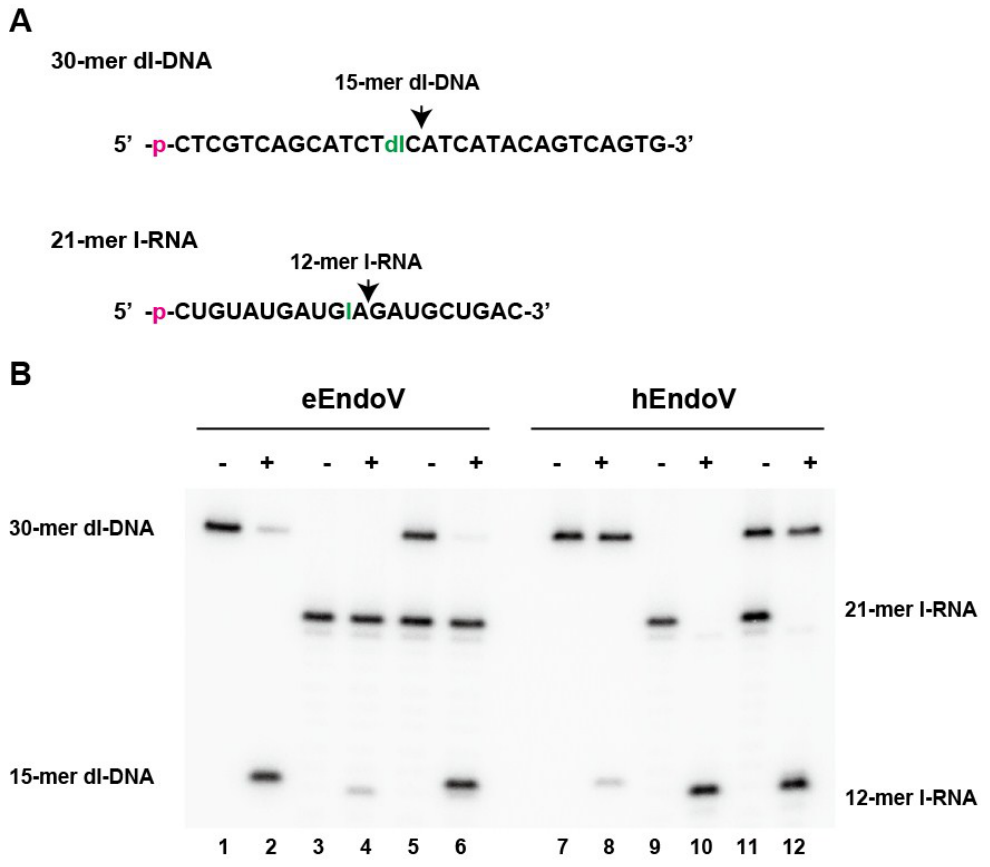
Figure 5. E . coli endonuclease V (eEndoV) and human endonuclease V (hEndoV) display opposing preferences in cleaving RNA and DNA. ( A ) 32 P-labelled 30-mer ssDNA containing deoxyinosine and 21-mer ssRNA containing inosine (dI and I, respectively) were used as substrates. The positions of cleavage are indicated by arrows; ( B ) Activity of eEndoV (lanes 1–6) or hEndoV (lanes 7–12) when incubated with 32 P-labelled DNA substrate (30-mer dI-DNA) containing deoxyinosine (lanes 1–2 and lanes 7–8) or 32 P-labelled RNA substrate (21-mer I-RNA) containing inosine (lanes 3–4 and lanes 9–10) or both DNA and RNA substrates (lanes 5–6 and lanes 11–12) at 37 °C for 30 min. The cleavage products (15-mer dI-DNA and 12-mer I-RNA) are indicated by denaturing polyacrylamide gel analysis. Conversion of adenosine residues to inosine within dsRNA is catalyzed by ADARs (Figure 6). As hEndoV cleaves at a locally distorted ssRNA structure containing inosine, it might be able to act on partially unwound dsRNA hyperedited by ADAR1, given that it could cleave dsRNA treated by ADAR2 [13]. hEndoV cleaves ssRNA containing inosine but not dsRNA; therefore, might require ADARs that have dsRNA unwinding activity. Thus, hEndoV might participate in the degradation of edited dsRNA (e.g., long viral dsRNA genome). In addition, hEndoV cleaves inosine at a biologically important site for deamination in the transcript of a neurotransmitter [44–46], suggesting that this enzyme is involved in normal RNA